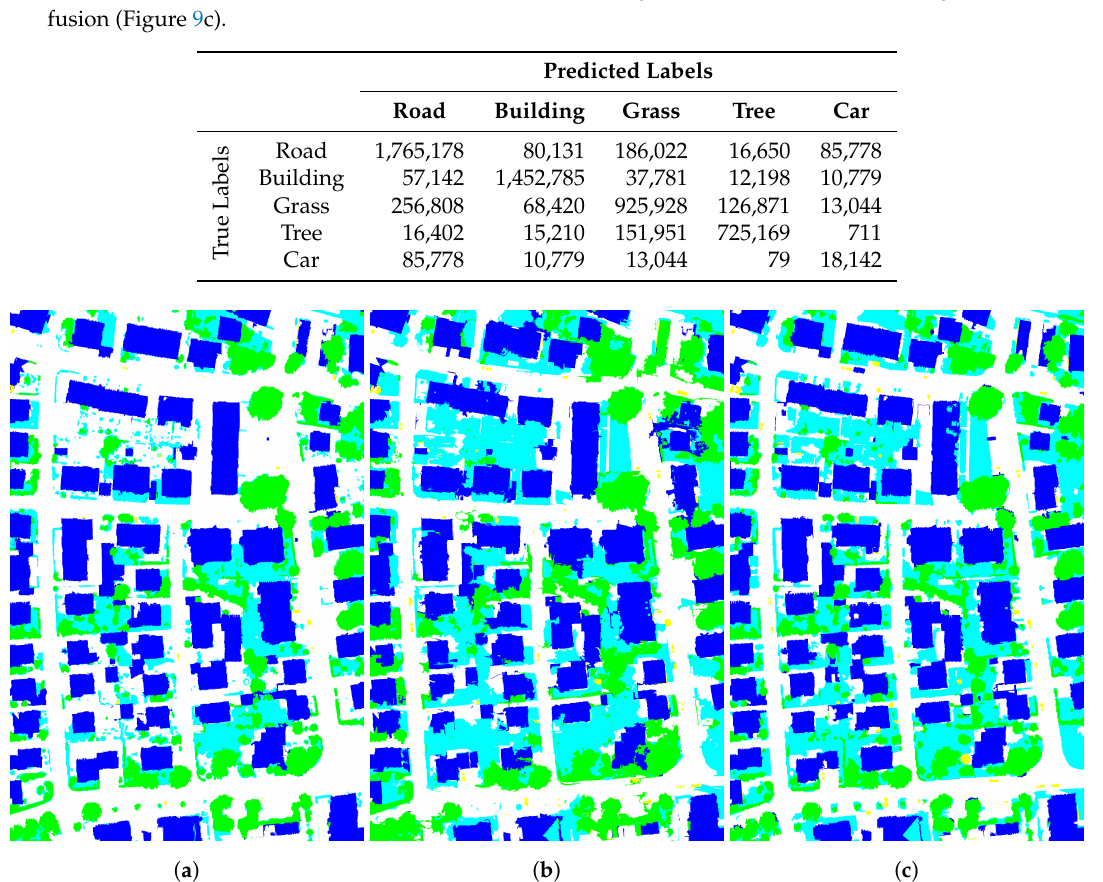
Figure 9. ( a ) Post-classification fusion of four individual classifications derived from Felzenszwalb and mean shift segmentations on IRRG and nDSM respectively, ( b ) classified Felzenszwalb segmentation based on a before segmentation fusion of IRRG+nDSM, ( c ) classified mean shift segmentation based on a before segmentation fusion of IRRG+nDSM. The colors used for the classes are as follows: building (blue), low vegetation (cyan), tree (green), impervious surface (white), car